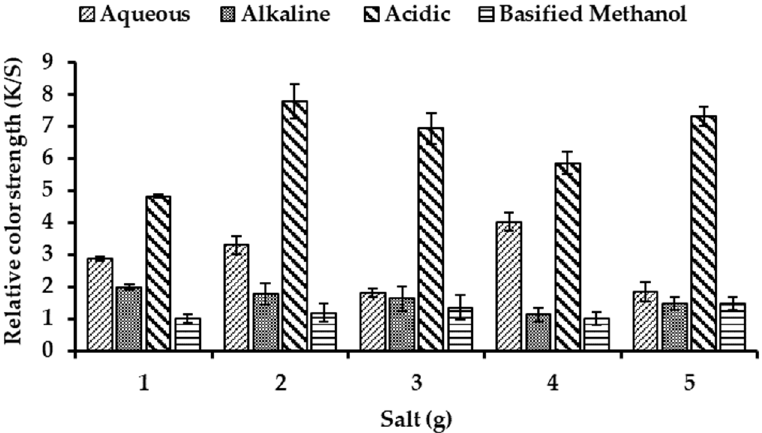
Figure 7. Dyeing of wool with rose extract using various amounts of salt.